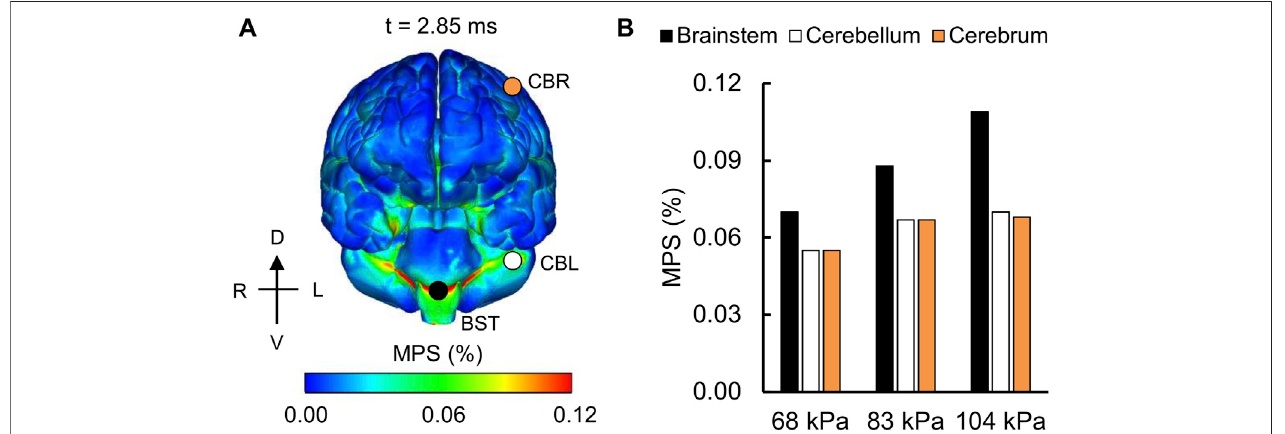
FIGURE 7 | Simulation showing the variation of the maximum principal strain (MPS) as a function of brain location. (A) Contour map showing the model-predicted MPS distribution throughout the outer surface of the brain for the 104 kPa blast overpressure at t (cid:1) 2.85 ms into the simulation. CBR: cerebrum (orange circle); CBL: cerebellum (white circle); BST: brainstem (black circle). (B) Bar graph comparing the peak MPS for the 68, 83, and 104 kPa blast overpressures. D: dorsal; V: ventral; R: right; L: left.